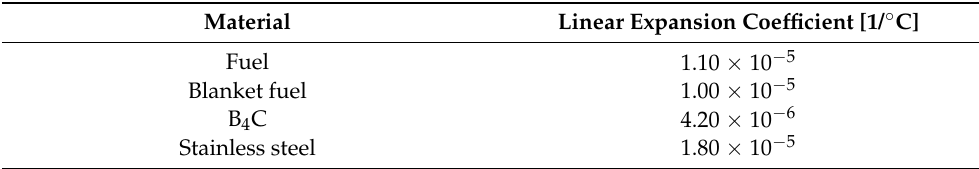
Table 1. Thermal expansion coefficients of various materials